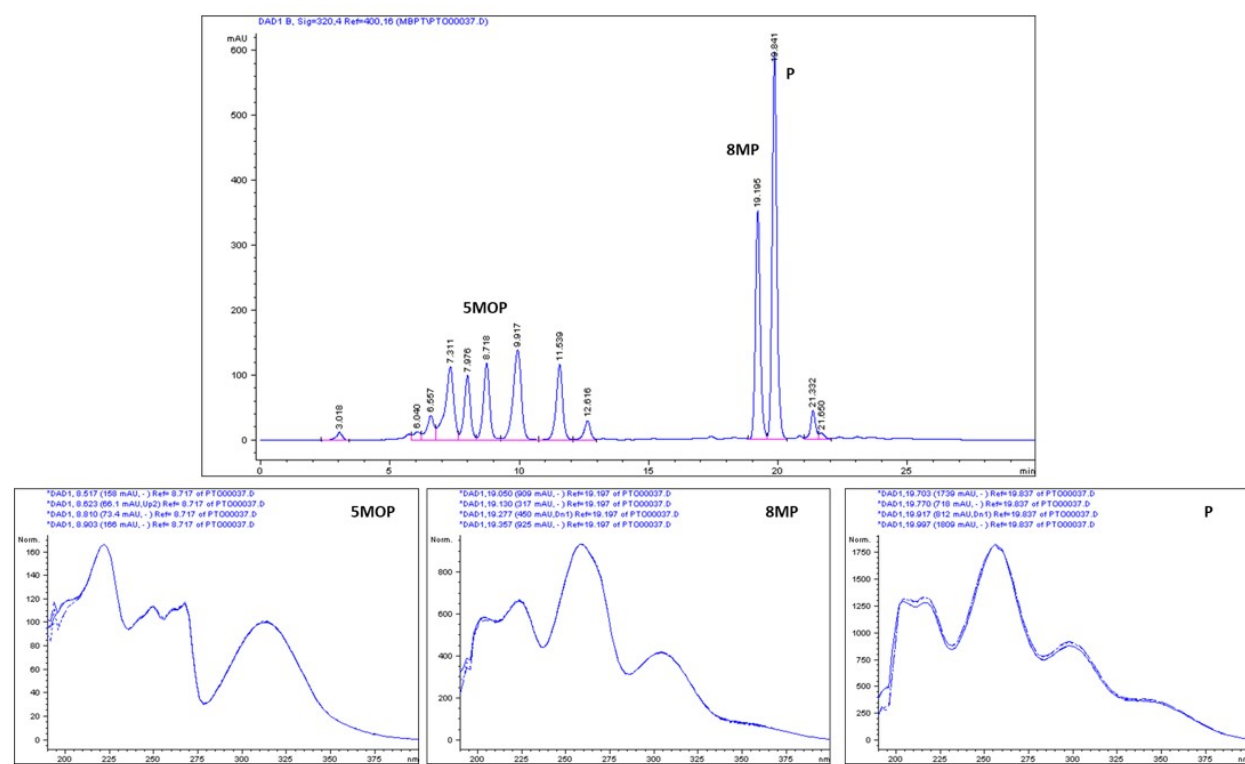
Figure 3. RP-HPLC chromatogram of the crude coumarin extract from P. tauricum fruits, with the DAD/UV spectra of targeted methoxyfuranocoumarins: 5MOP (bergapten), 8MP (8-methoxypeucedanin), and P